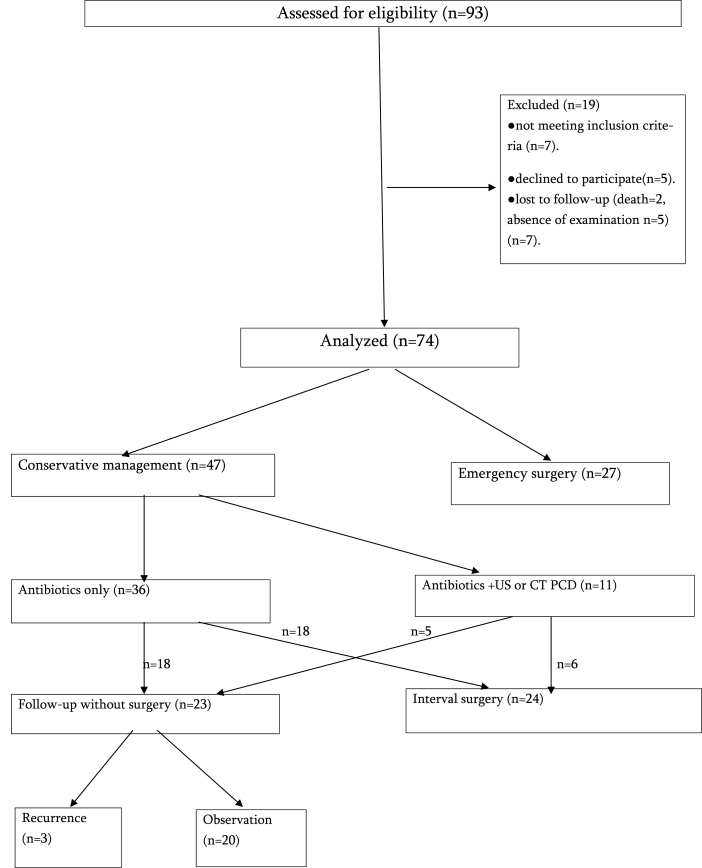
Study flow chart.